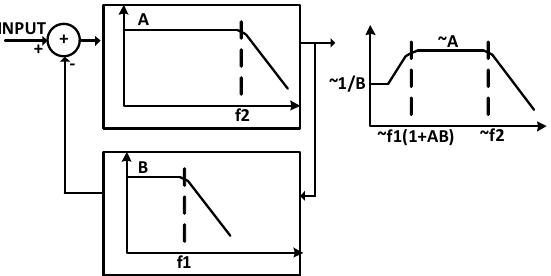
Figure 2. Implementing a high-pass pole using a low-pass filter in the